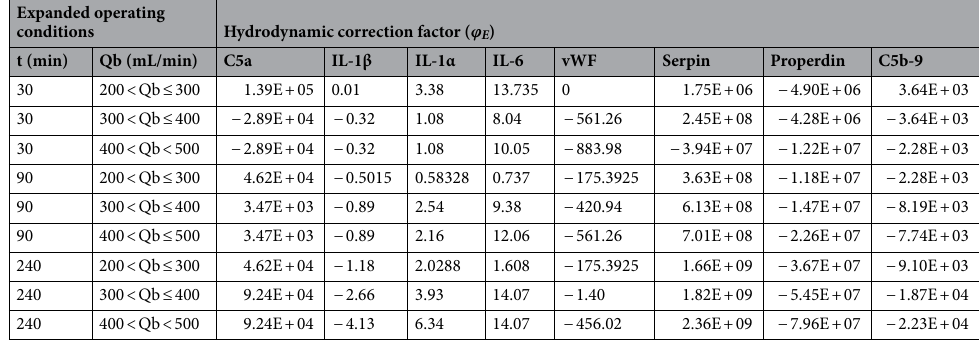
Table 1. Hydrodynamic correction factors ( ϕ E ) for expanded model for CTA and PAES-PVP membranes.